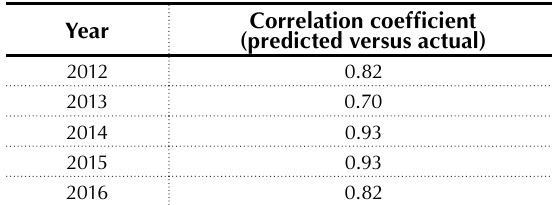
Table 4. Correlation coefficient between the predicted versus actual normalized Innovation Ranking of the top innovators for the period 2012–2016